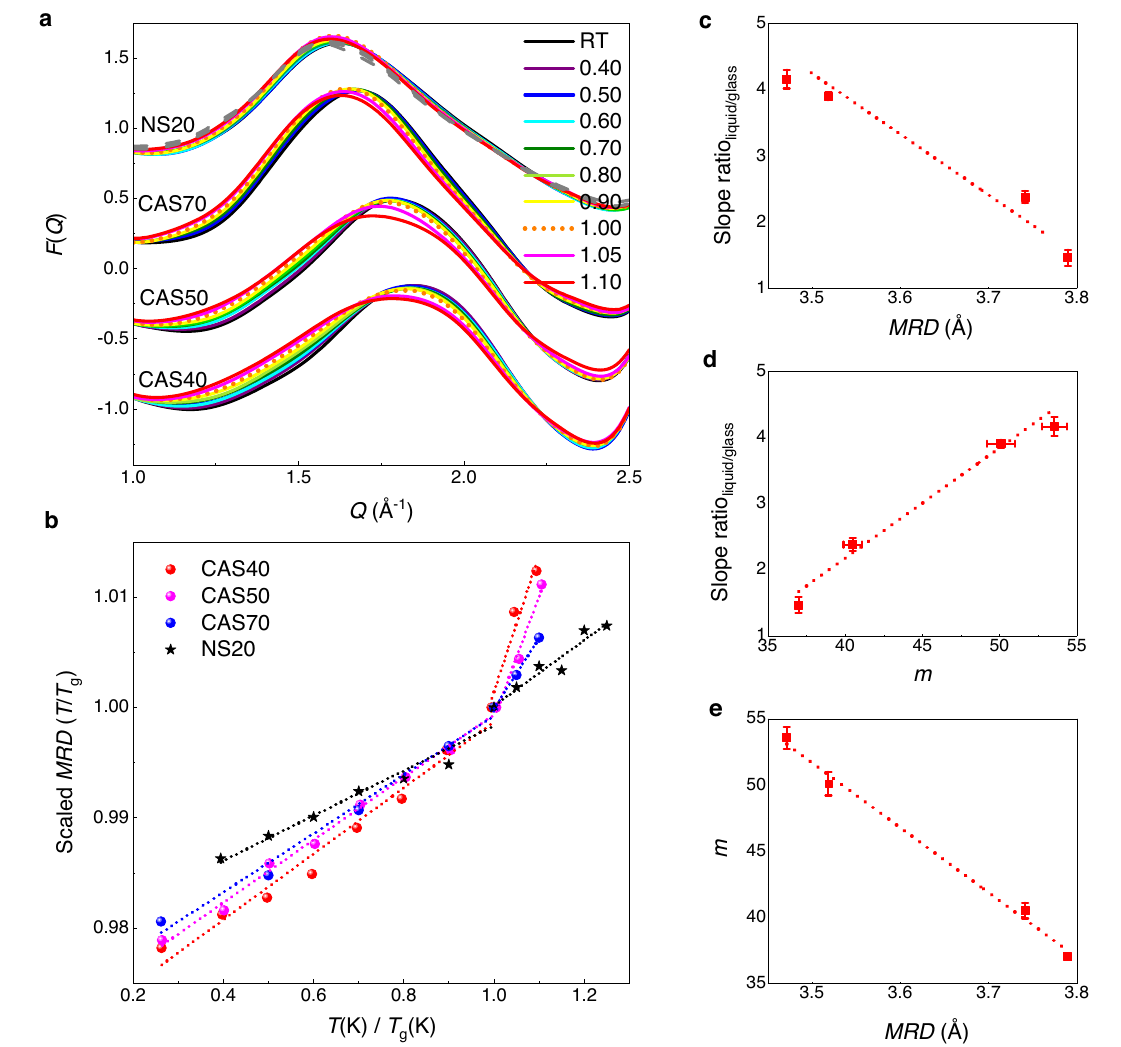
Fig. 6 | Structural origin of the m - MRD correlation revealed by in-situ neutron total-scattering analysis. a FSDP regions of F ( Q ) of three CAS glasses measured fromroomtemperatureupto1.1 T g andNS20glassfromRTto1.25 T g .TheRT − F ( Q ) is plotted in black, then the color changes following the rainbow color spectrum, untilthe F ( Q ) of 1.1 T g is plotted in red.The three F ( Q )s with T higherthan1.1 T g for NS20 glass are plotted by gray dashed lines. Both CAS40 and CAS50 glasses were measured at ten temperatures, as labeled in the fi gure legend; due to time limita- tions,CAS70wasonlymeasuredatseventemperatureswith T =0.4,0.6and 0.8 T g skipped. b An analogous OLUA plot of scaled- MRD T / MRD T g as a function of scaled